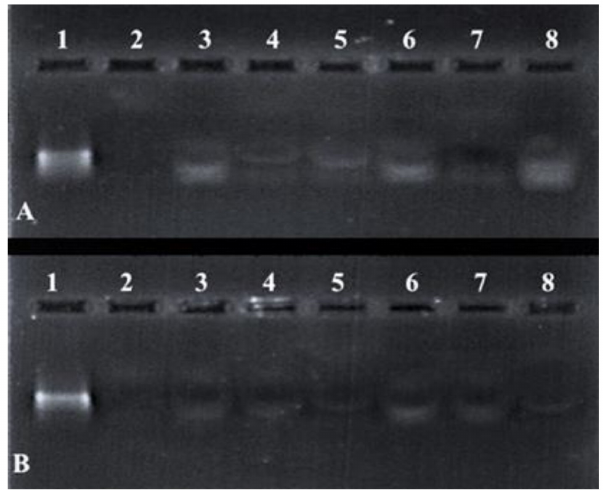
Figure 7. Nuclease protection assay of mRNA: FSeNP nanocomplexes. Lane 1: Positive control (naked mRNA (0.3 µ g)). Lane 2: Negative control (mRNA + 10% serum). Nanocomplexes at sub- optimum, optimum, and supra-optimum w / w binding ratios–( A ) Lanes 3–5: CS-SeNP (1:4.5, 1:5 and 1:5.5) and Lanes 6–8: LA-CS- SeNP (1:5.5, 1:6 and 1:6.5); ( B ) Lanes 3–5: PEG-CS-SeNP (1:4.5; 1:5